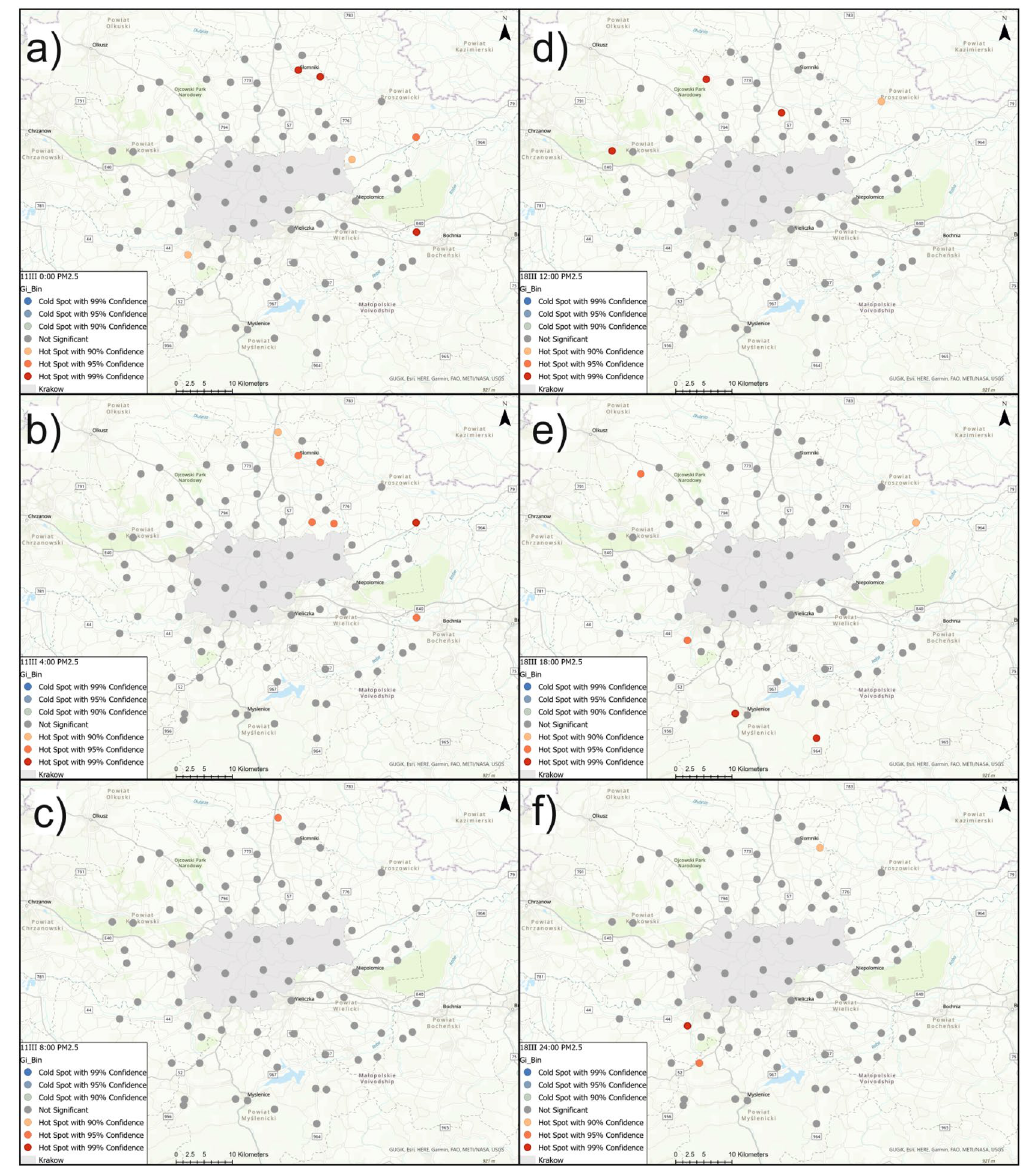
Figure 8. Hot-spots and cold-spots maps for PM2.5 concentration on March 11th and March 18th using Getis– Ord G